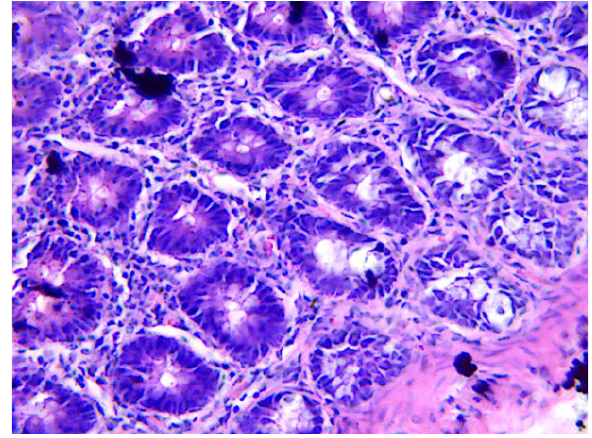
Fi gur e 2 d: H i gh dose groups.